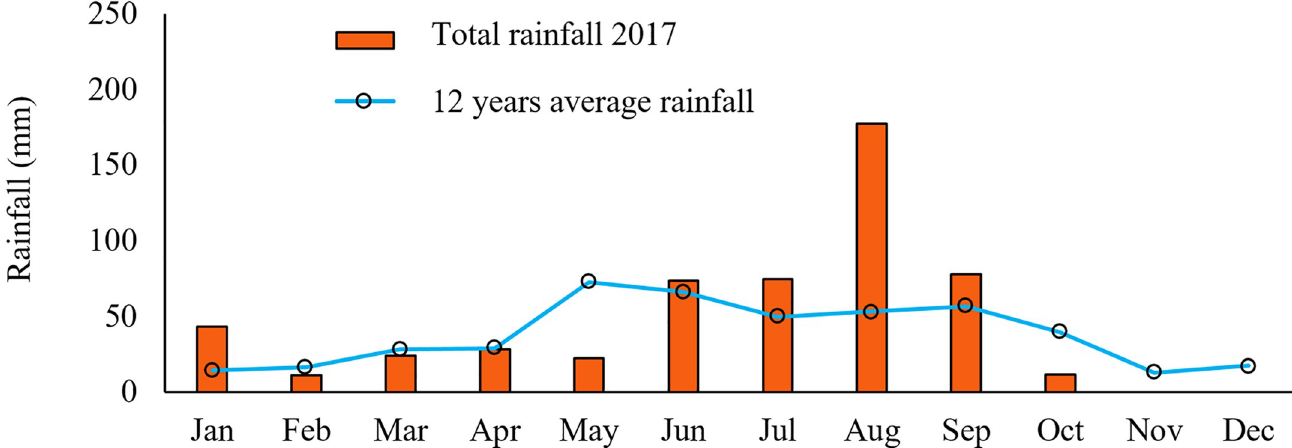
Fig 3. Monthly rainfall for 2017 and the 12-year average for the area at the study site in Hale County, Texas.